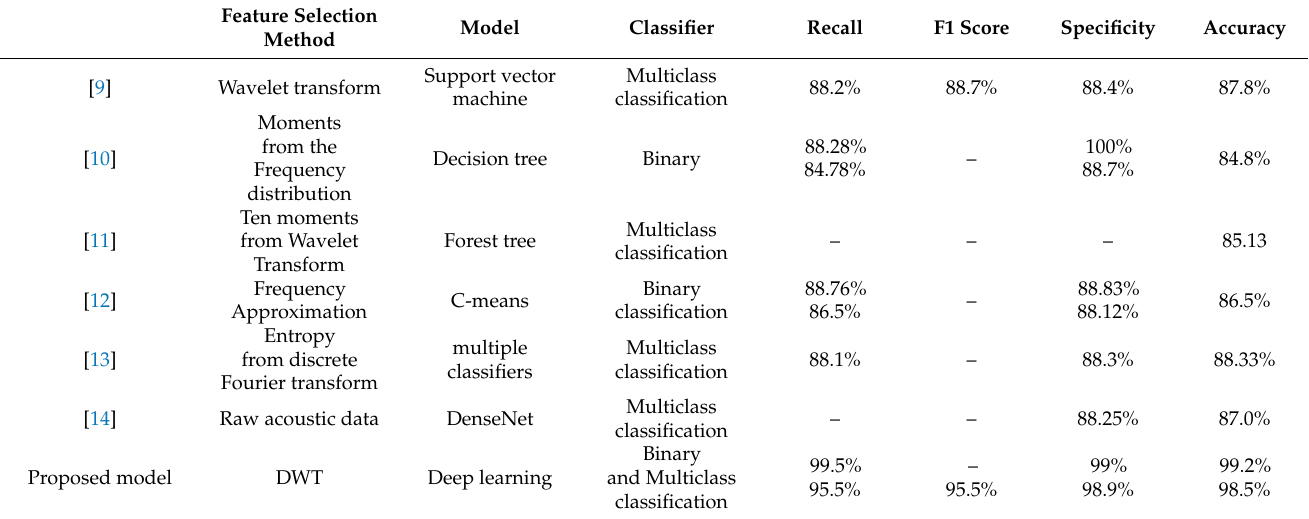
Table 1. Comparison between models that utilized the same